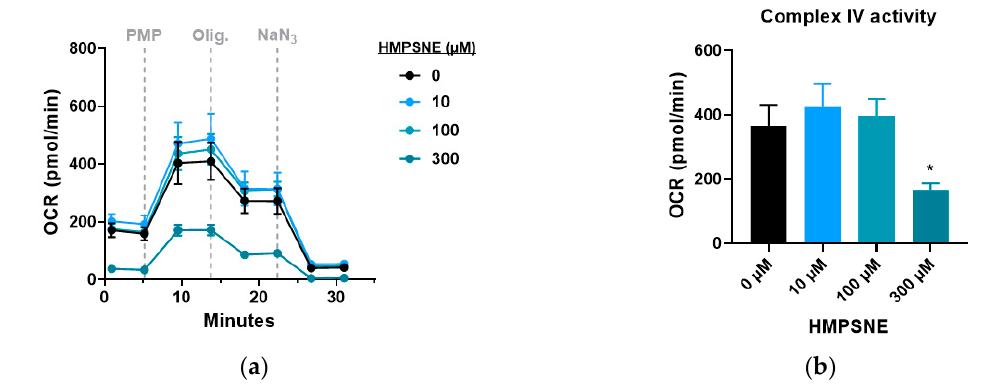
Figure 11. Effect of HMPSNE on Complex IV activity in CT26 cells: ( a ) Proton efflux rate (PER) profiles in control cells and HMPSNE treated cells. Dashed lines indicate the addition of specific mitochondria stressors into the media. Results are indicated as mean ± SEM of three replicates per condition; ( b ) Analysis of Complex IV activity calculated by the difference between maximal and minimal OCR. Results are indicated as mean ± SEM of three independent replicates per condition, and unpaired t tests are shown vs. 0 µM (* p < 0.05, ** p < 0.01, *** p < 0.001).